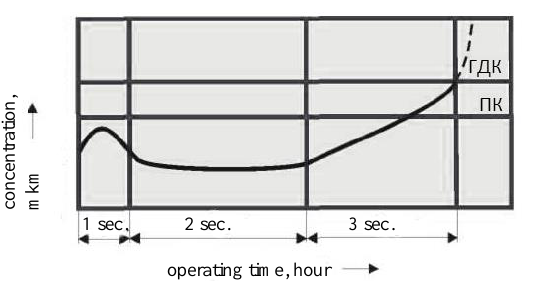
Fig.1. The normal law of change in the content of metals in the oil in the course of engine operation. PC - increased concentration, at achievement of which the engine is allowed to operate under "special control". MPC - maximum permissible concentration,